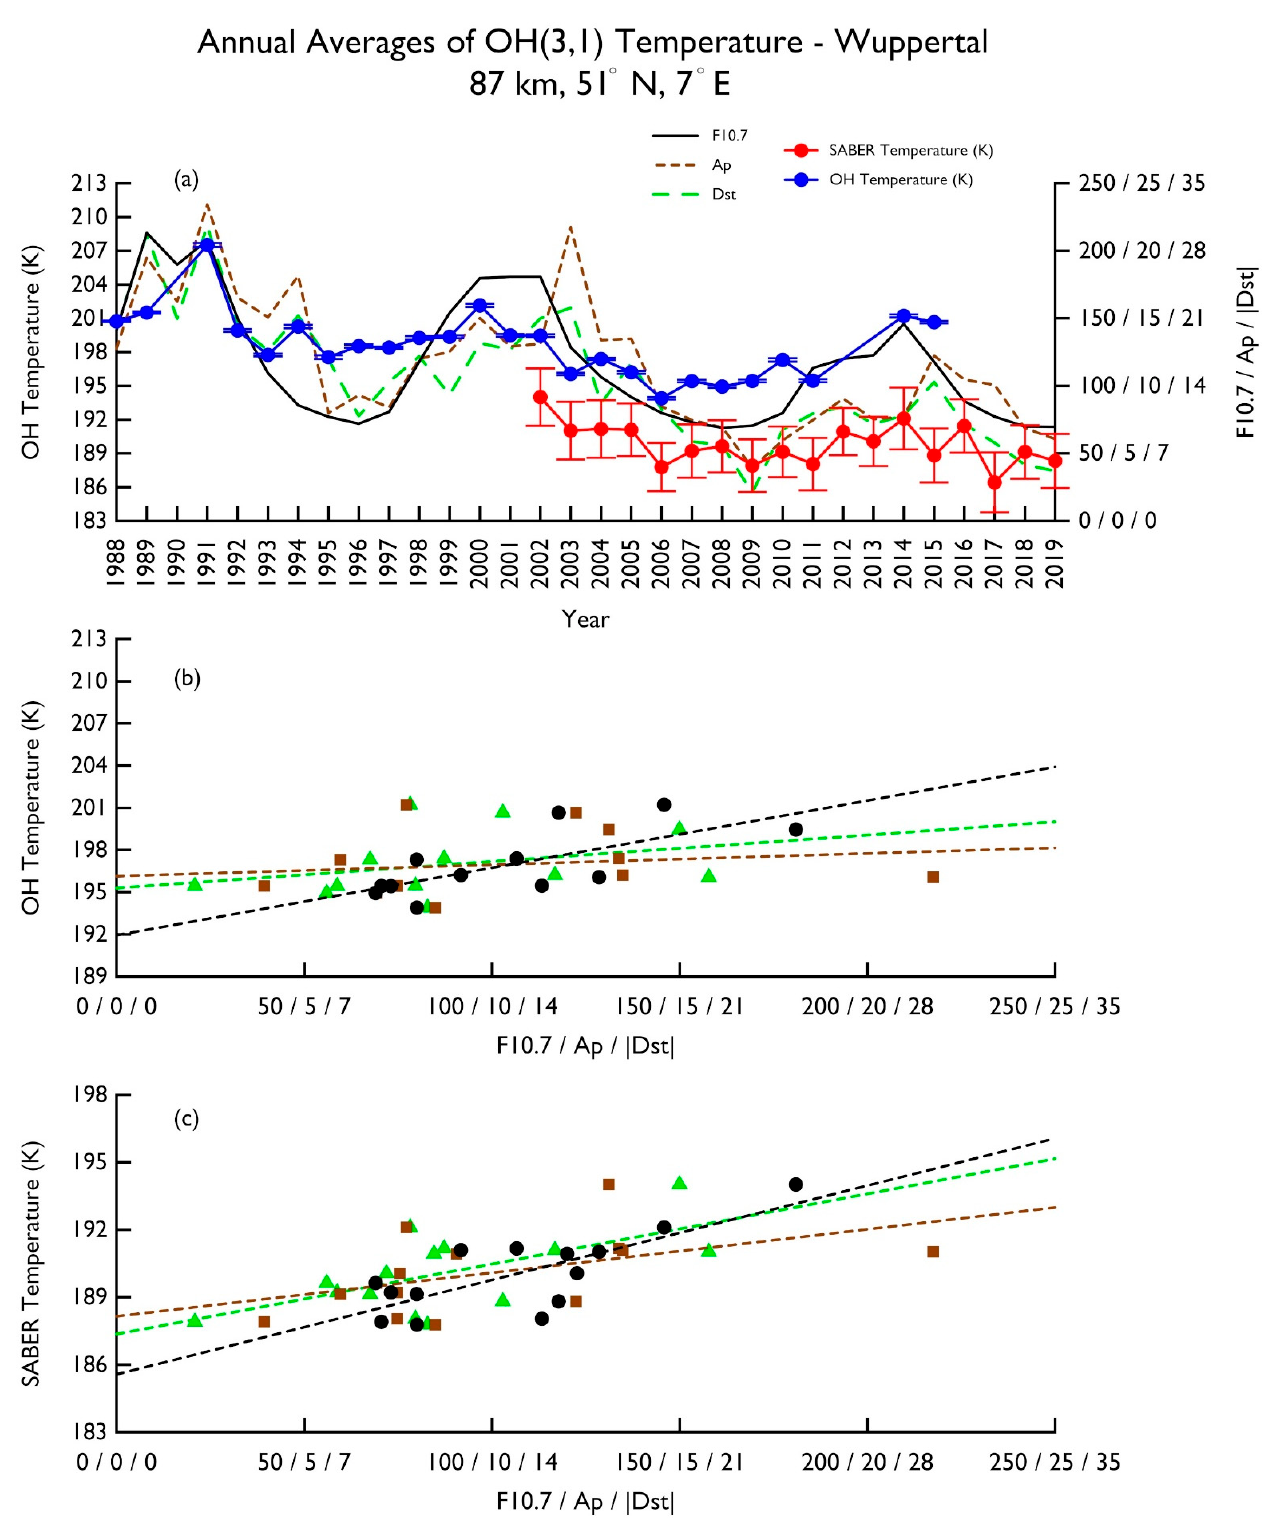
Figure 2. ( a ) Annual averages of OH(3,1) temperatures at Wuppertal (blue line with dots) and annual averages of SABER temperatures (red line with dots) at the same location at 87 km altitude. The error bars show the range of uncertainties of temperature. Also plotted are annual averages of F10.7 (black line), Ap index (brown dashed line), and |Dst| index (green dashed line). ( b ) WUP temperatures plotted as a function of F10.7 (in black), Ap index (in brown), and |Dst| index (in green) with the respective trend lines. ( c ) SABER temperatures plotted as a function of F10.7, Ap index, and |Dst| index with the respective trend lines.